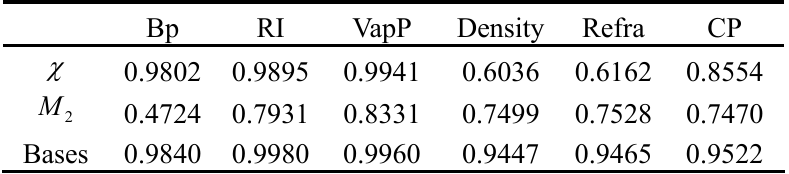
, the connectivity character 2